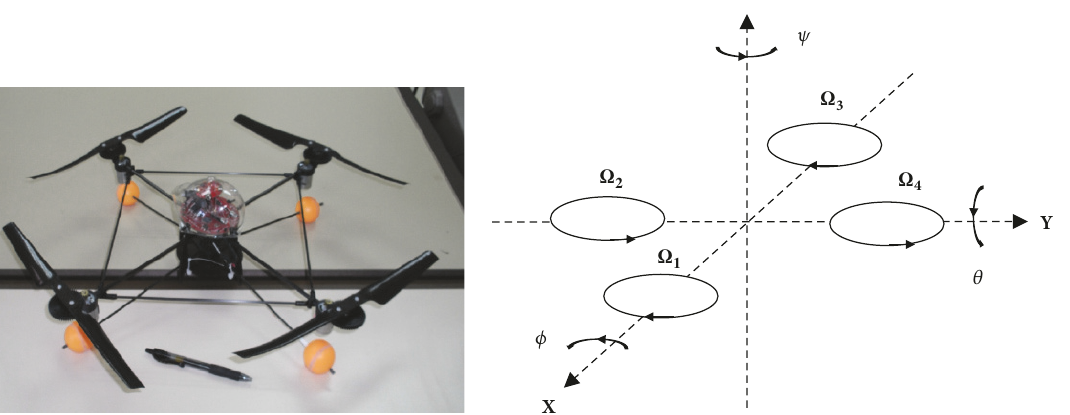
Figure 1: A quadrotor vehicle (left) and UAV’s coordinate system